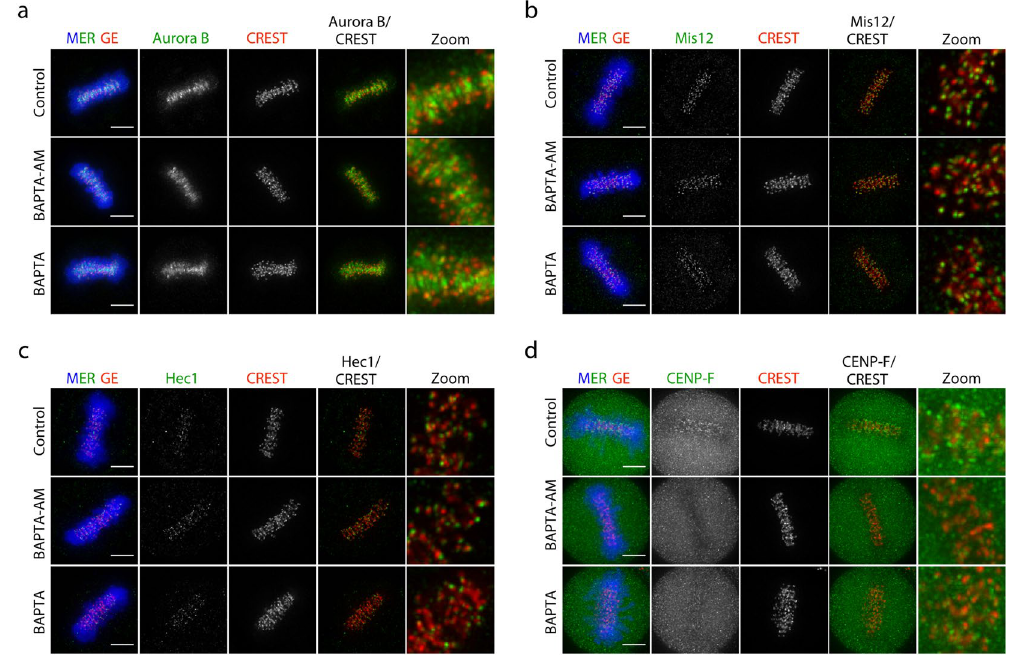
Figure 4. Ca 2 + -depletion causes defects in the localisation of CENP-F at the outer kinetochore. Fluorescence images of metaphase cells after control, BAPTA-AM and BAPTA (with ionomycin) treatments for the localisation of Aurora B ( a ), Mis12 ( b ), Hec1 ( c ) and CENP-F ( d ). Bar, 5 µ